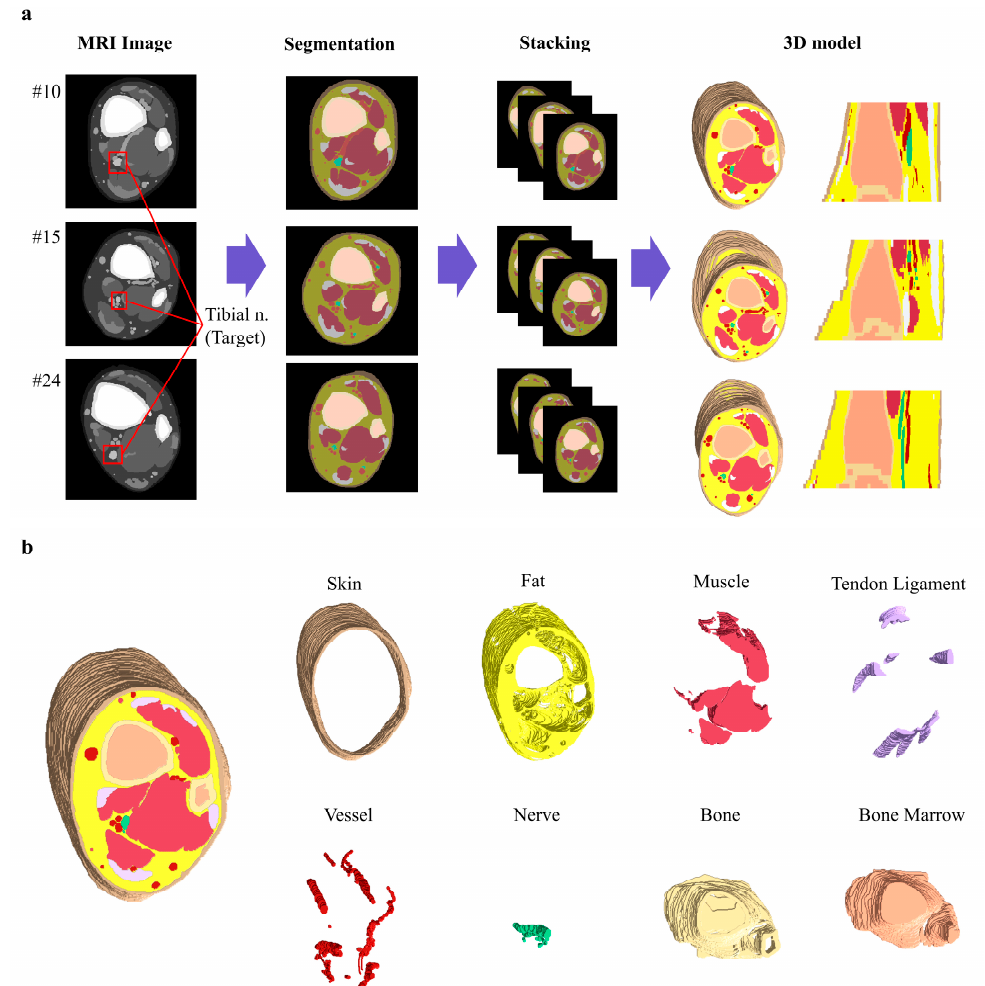
Figure 2. Models based on MR data ( n = 29) and tissue composition. ( a ) Construction process of a 3D lower leg model based on MR data. ( b ) Tissue composition in the construction model. For visibility, the tendon ligament has been colored purple only in that figure. Table 2. Conductivity of each material included in the